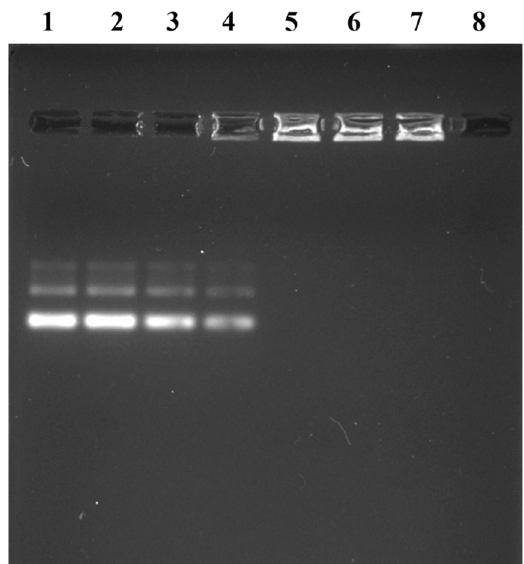
Figure 3. Nanoparticles Binding with siRNA. Nanoparticles 1 µ g to 7 µ g (left to right) while RNA is same (10 µ g) in each of the well. Well 8 contains only nanoparticles.